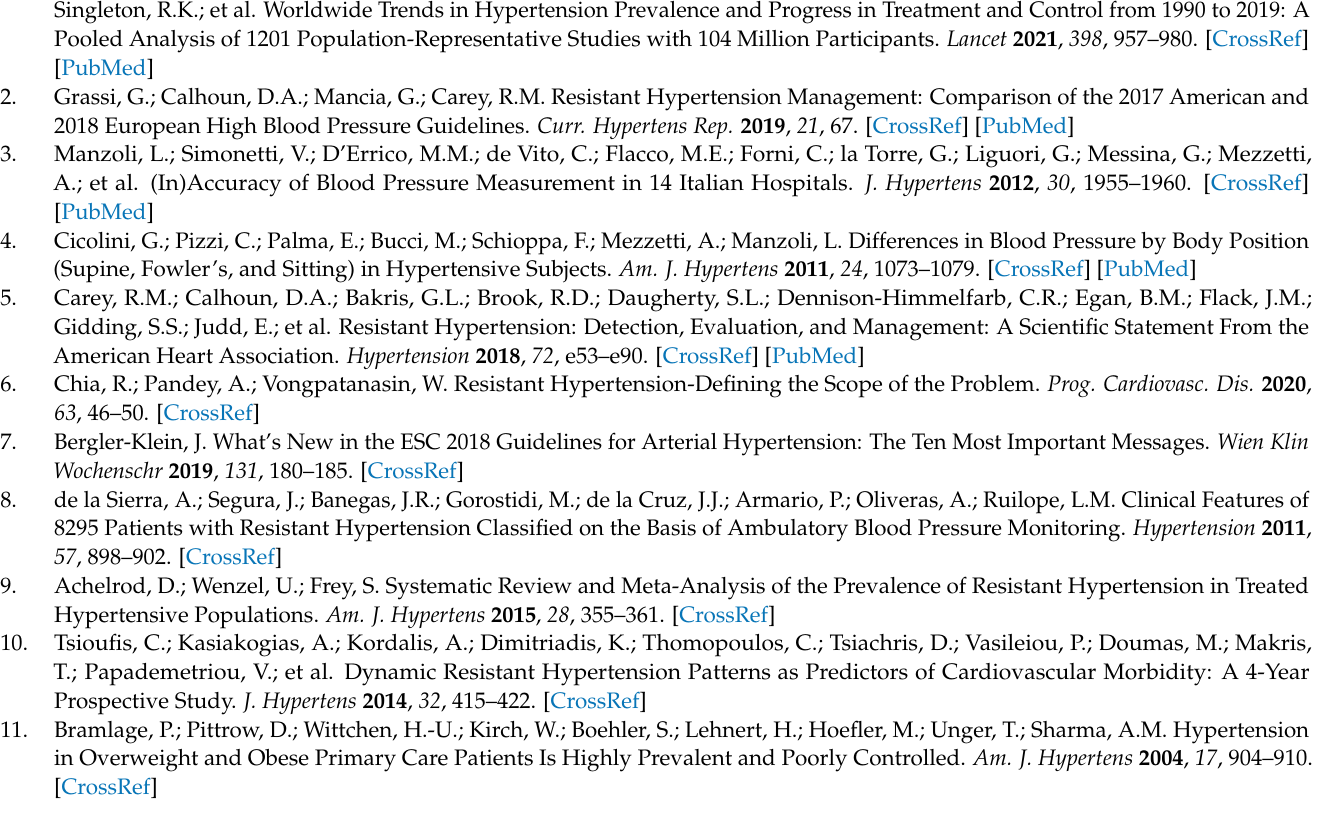
Figure S2: Variables affecting the different responses to intervention; Table S1: Laboratory assessments in blood and